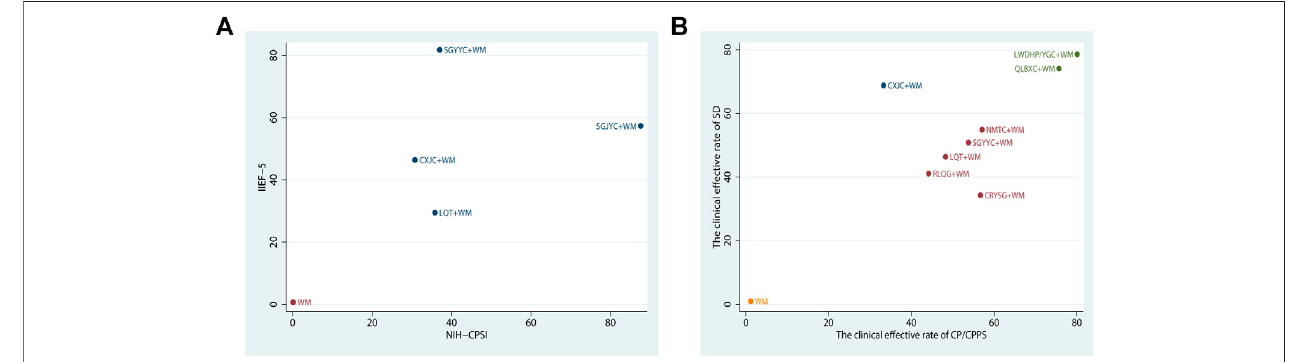
FIGURE 7 | Cluster analysis plots. Interventions located in the upper right corner indicate optimal combination therapy for two different outcomes.